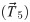
Affine Extensions.We construct the affine extensions of the base icosahedral vertex sets by first translating the polyhedra along one of its symmetry axes, and then applying icosahedral symmetry to the displaced structure. Here we show the base icosahedron (blue) being translated along the 5-fold axes (T→5) to form a new icosahedron (green) displaced from the origin. Once icosahedral symmetry about the blue icosahedron is applied, the displaced vertices create new polyhedra at different radii. The displacement lengths are chosen such that at least two of the original vertices intersect the original symmetry axes or intersect neighboring displaced vertices [10]. In this way, we construct a new icosahedral vertex set, adding a radial component to the original icosahedral symmetry. In this example, we intersect the 3-fold axes (3→1,2) and thus will create a new larger radius dodecahedron. The top vertex of the original icosahedron which now resides at the tip (green) of T→5 will be the largest radius point, and thus the gauge point of this affine extension.